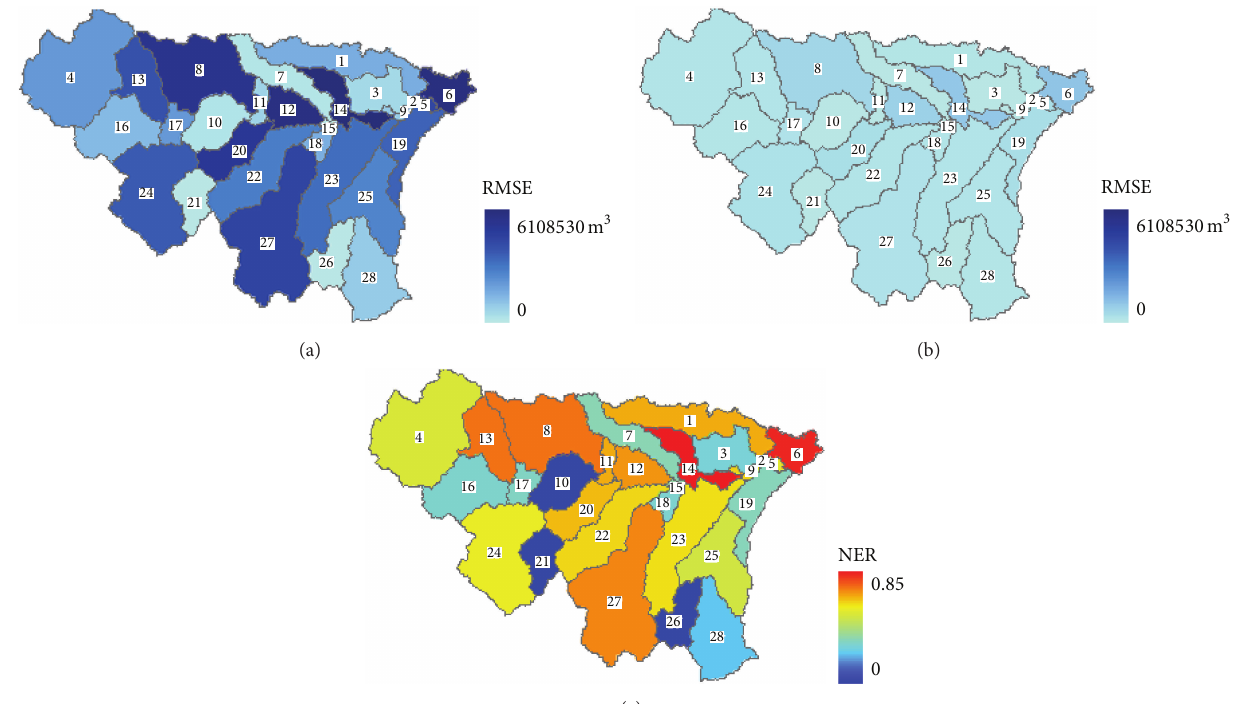
Figure 7: RMSE of the estimated river flow storage ( 𝑉 ) on 28 subbasins by (a) EnOL and (b) EnKF for the whole assimilation period. (c) stored . 1 to 28 are the subbasin NER (18) of the estimated 𝑉 stored